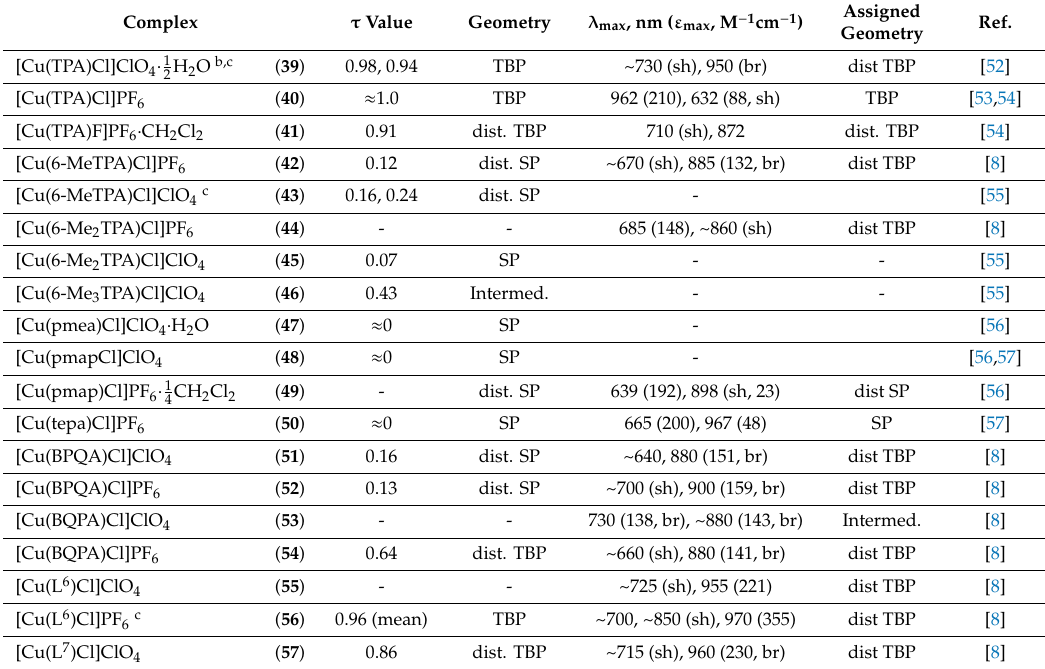
Table 3. The molecular structure, the distortion index parameter ( τ ), the visible spectral absorption bands of mononuclear five-coordinated halido-Cu(II) complexes a in acetonitrile solutions and the assigned